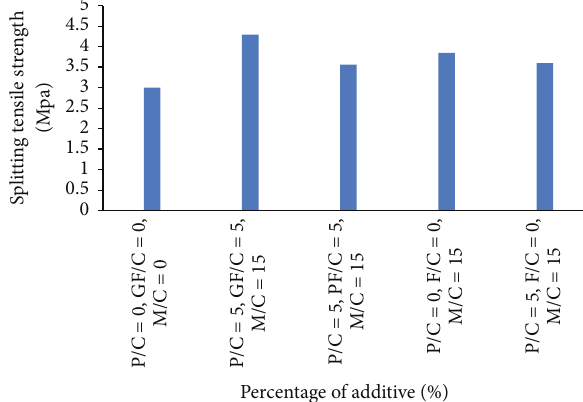
Figure 9: The compressive strength at different polymer contents at age of 28 days.